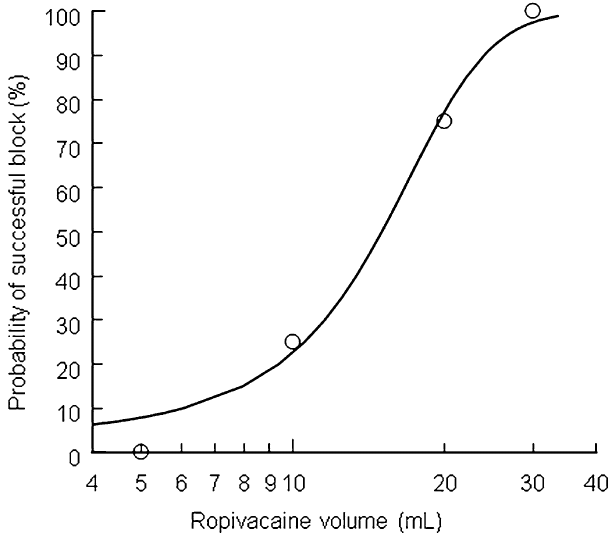
Figure 3. Dose–response curve for ropivacaine plotted from probit analysis. The minimum local analgesic volume of 0.25% ropivacaine for fascia iliaca compartment block was 15.01 ml (95% confidence interval CI − 6.53 ml ~ 22.99 ml), and the 95% effective volume was 26.99 ml (95% confidence interval CI 20.54 ml ~ 84.09.